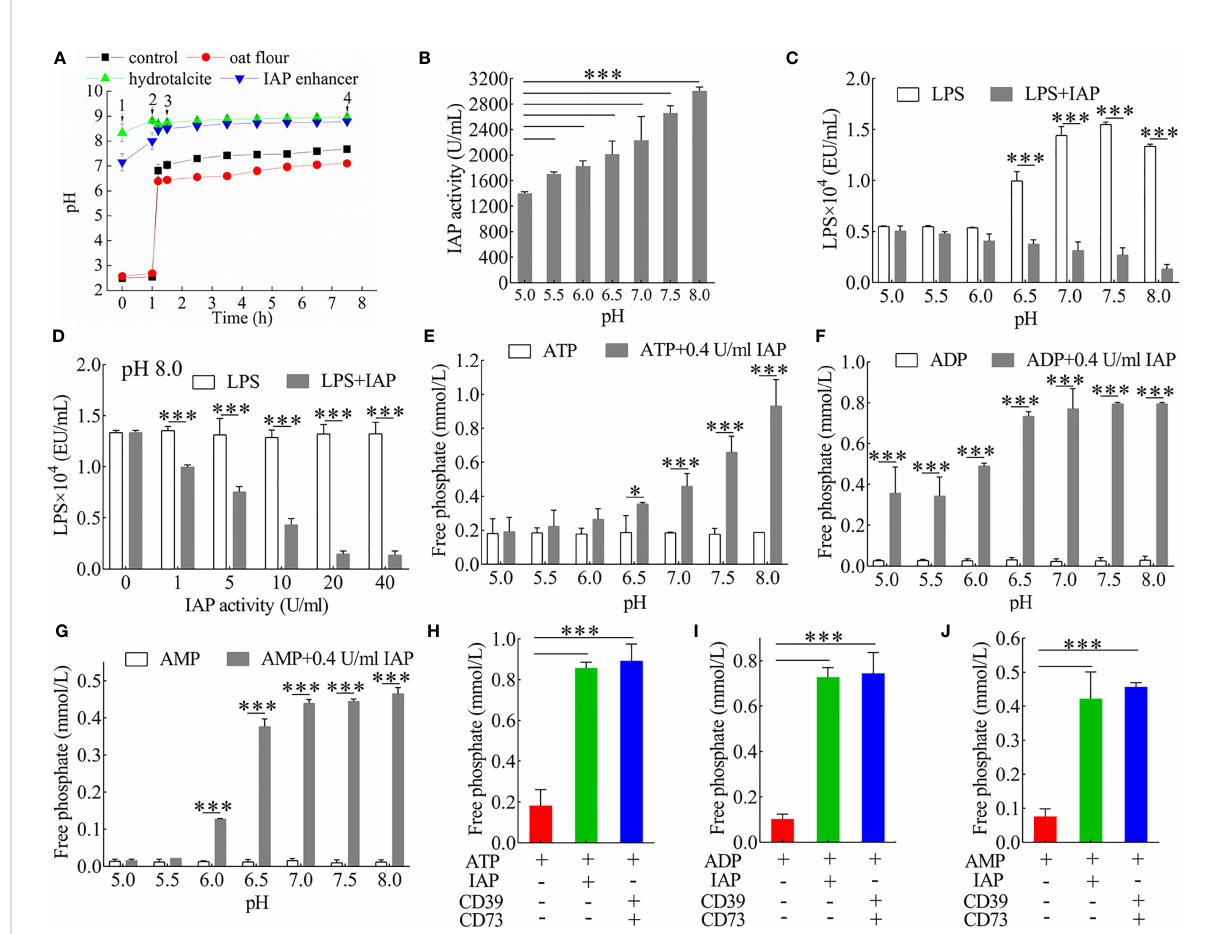
FIGURE 1 Analysis of the dephosphorylation properties of IAP. (A) Buffering capacity of IAP enhancer, hydrotalcite, and oat fl our during gastrointestinal stimulation in vitro . 1) Into the stomach; 2) into the duodenum; 3) into the small intestine; 4) into the large intestine. (B) The pH-dependent activity of IAP. The inactivation effect of IAP on LPS at (C) different pH levels and (D) different IAP activities. The dephosphorisation of (E) ATP, (F) ADP, and (G) AMP by 0.4 U/ml IAP at different pH levels. Dephosphorylation of (H) ATP, (I) ADP, and (J) AMP by IAP or CD39 + CD73. Values are presented as means ± SD (n = 3/group). Two-tailed unpaired Student ’ s t test. For multiple comparisons, analysis of variance with Tukey was used. *P < 0.05; ***P <